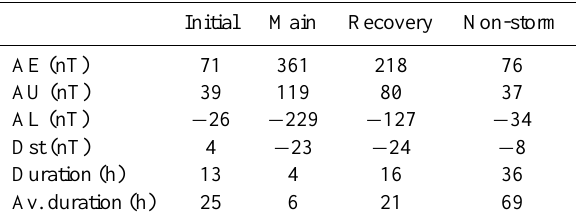
Table 2. Median values for activity indices and durations during all storm phases. The last row shows the mean duration values for the different phases.